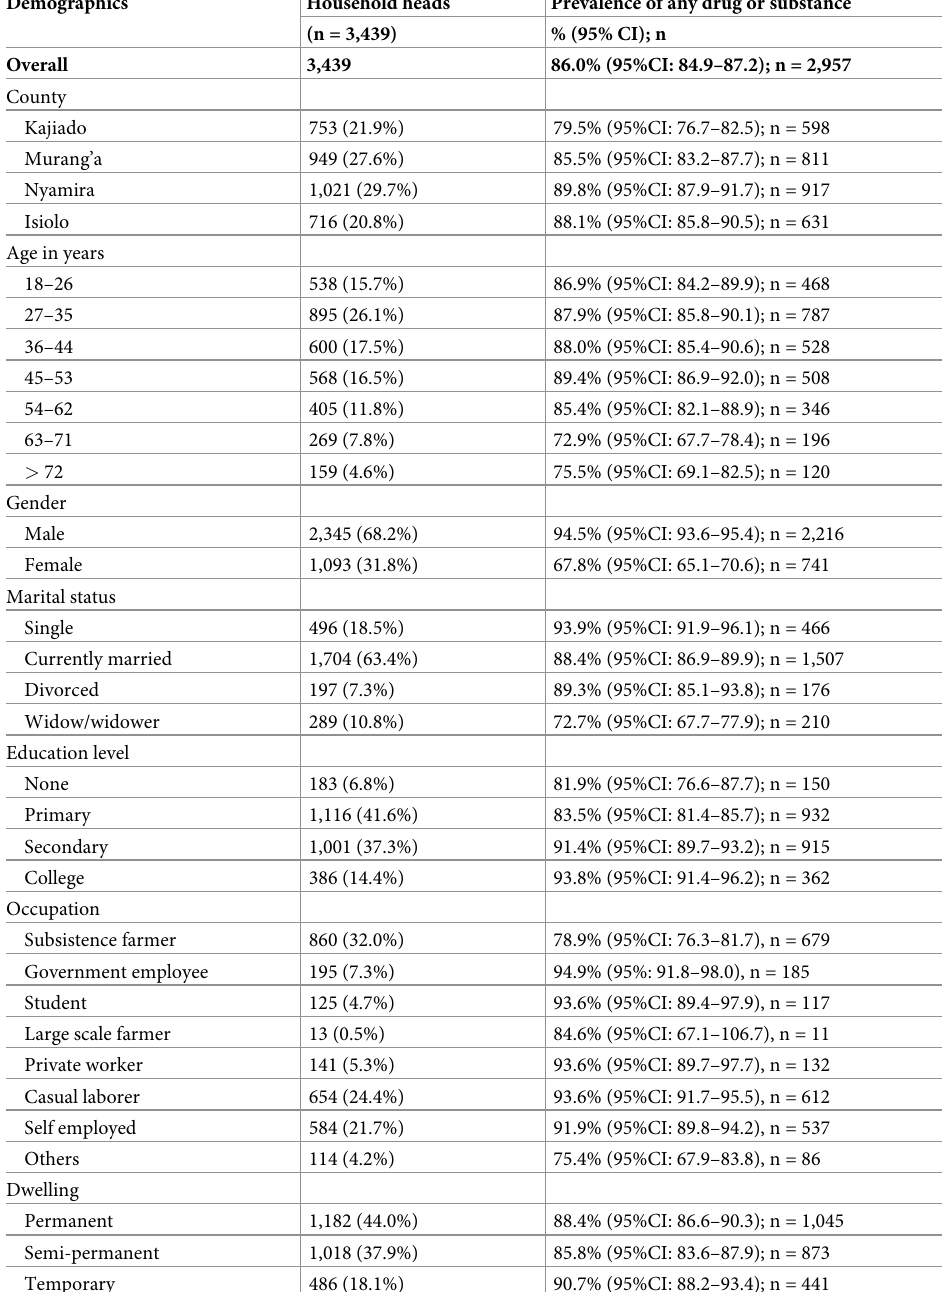
Table 1. Overall prevalence (%) of any drug and substance abuse.